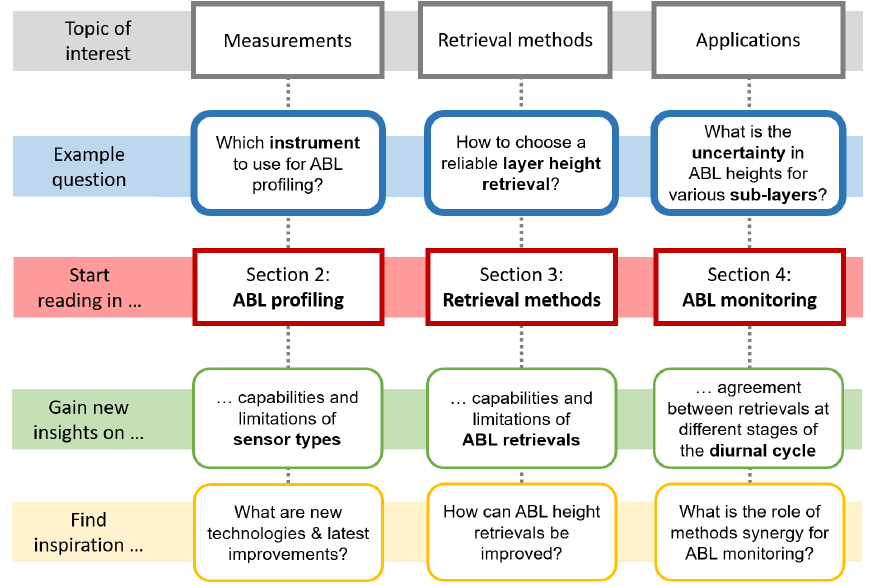
Figure 1. Entry points to this paper. The reader is invited to consult the respective section(s) related to their field of